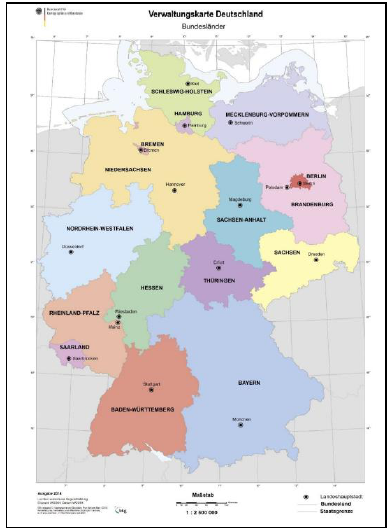
Figure 3. Data source for the collection of the